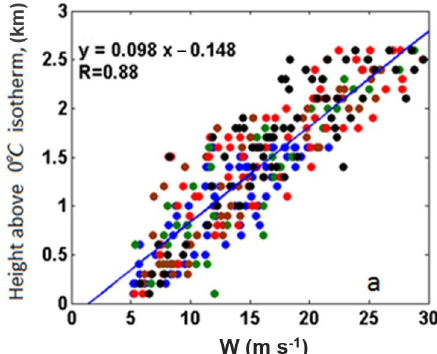
Figure 5. Cumulative histograms of Z DR column height ( left ) observed during Oklahoma tornadic storms on 19 May 2013 and ( right ) from an idealized storm simulated by the HUCM.